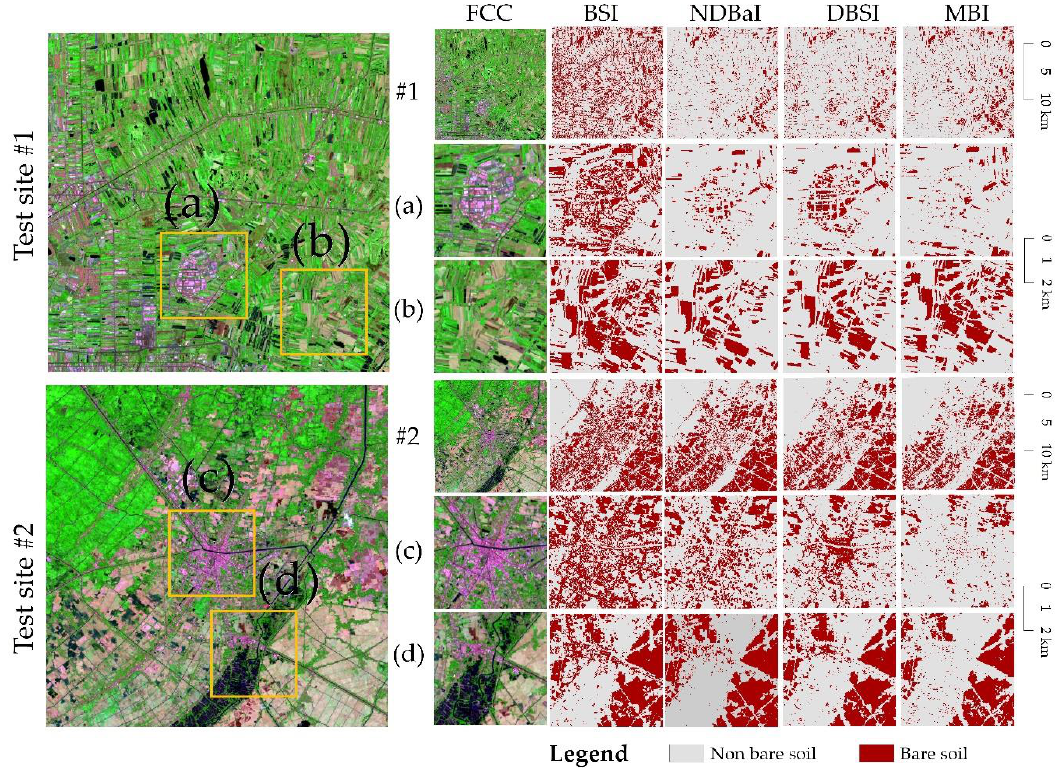
Figure 7. Spatial distribution of bare soil layers extracted from BSI, NDBaI, DBSI, and MBI on entire test sites and zoom-in areas in solid line squares where there were significant differences among the indices compared to FCC images: ( a , b ) Test site #1, ( c , d ) Test site #2 344